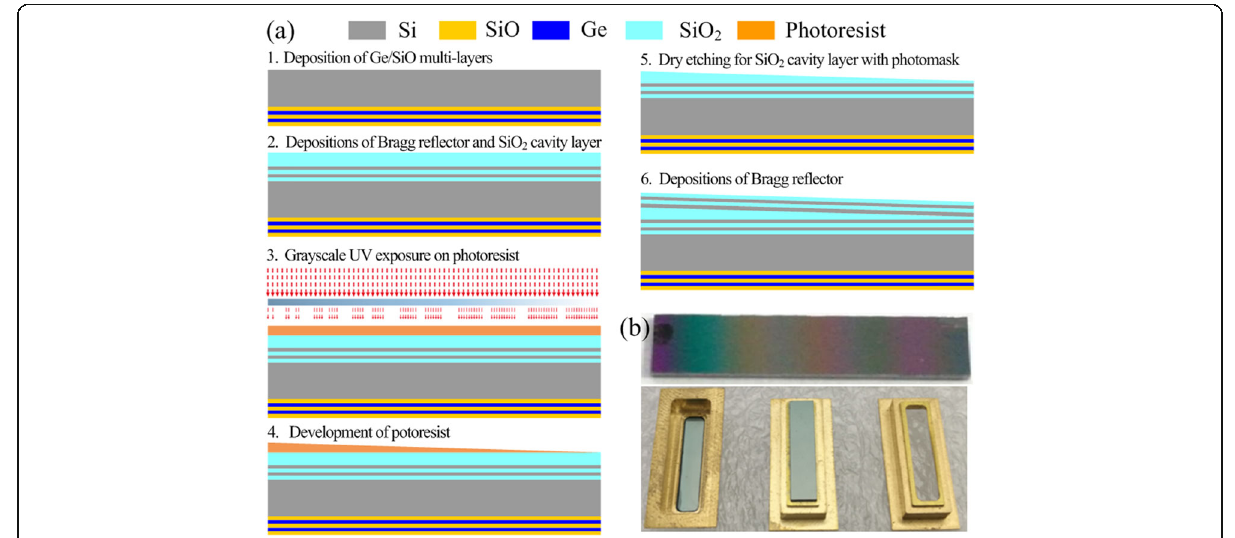
Fig. 5 a MEMS-based fabrication process flow. b Photographs of actual LVOF and its package